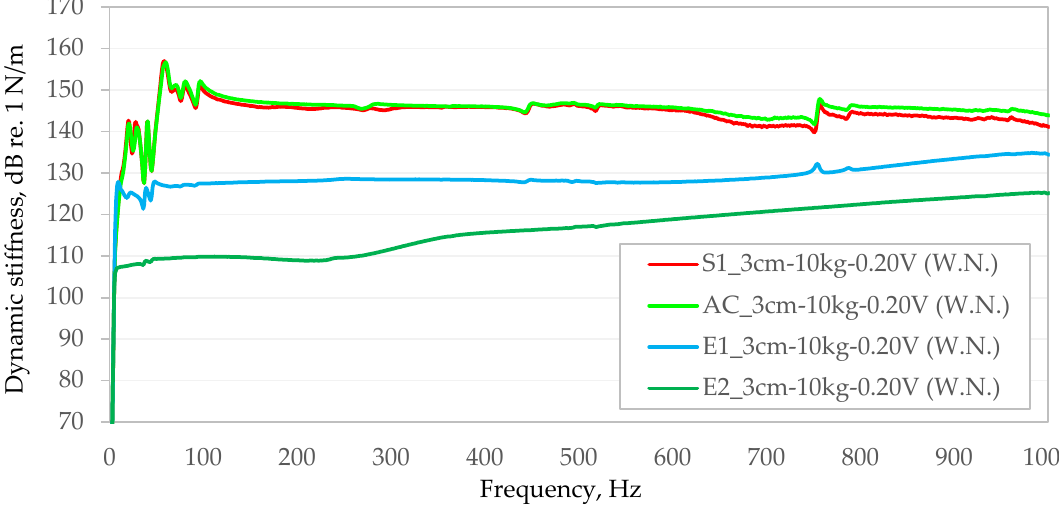
Figure 7. Comparison of dynamic stiffness of samples tested in the first stage.